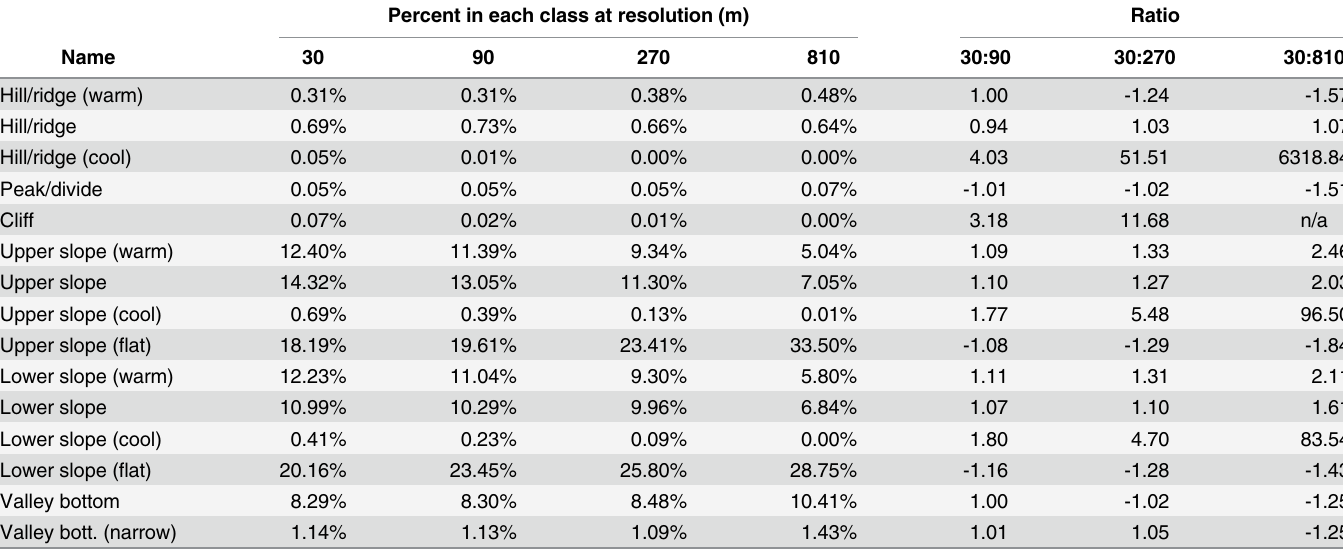
Table 2. Landform classes in the conterminous USA at different